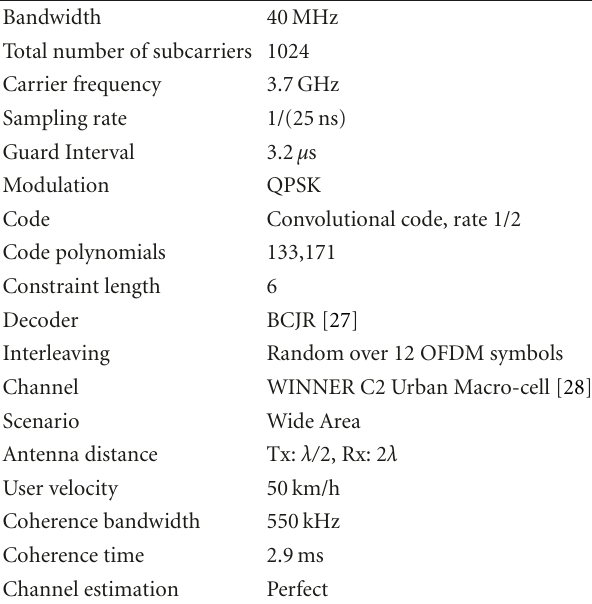
Table 1: Simulation